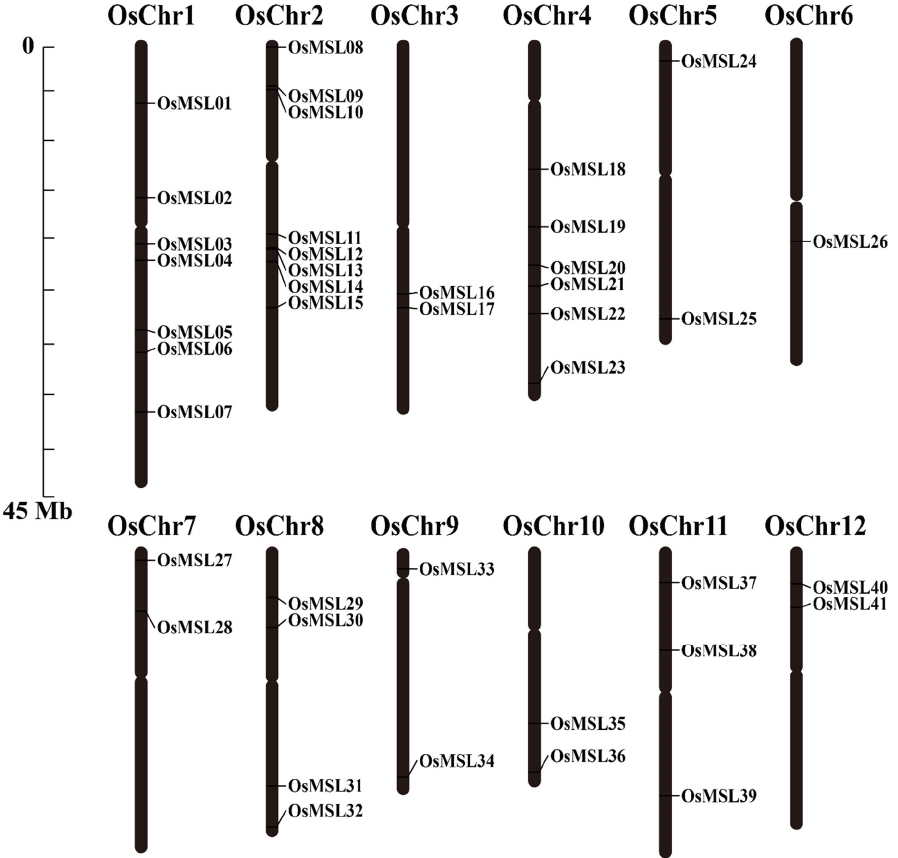
Figure 1. Chromosomal locations of rice trihelix genes. Black bars represent the chromosomes. Chromosome numbers are shown at the tops of the bar. Trihelix genes are labeled at the right of the chromosomes. Scale bar on the left indicates the chromosome lengths (Mb).